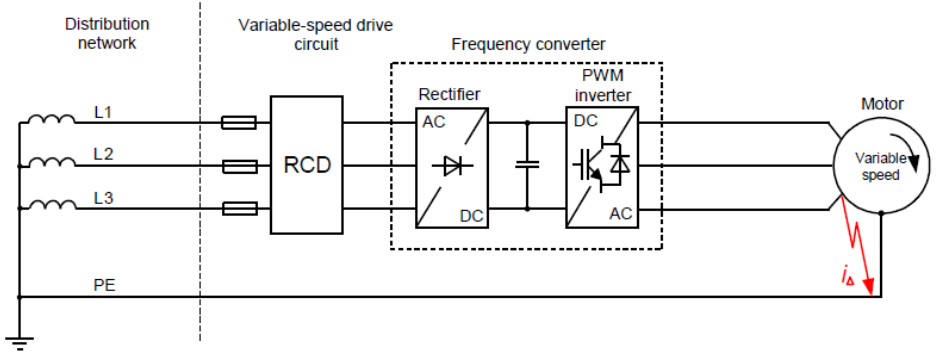
Figure 4. A variable-speed drive circuit producing residual currents of high-frequency components; RCD—residual current device; iD—residual current; PWM—pulse width modulation [17].